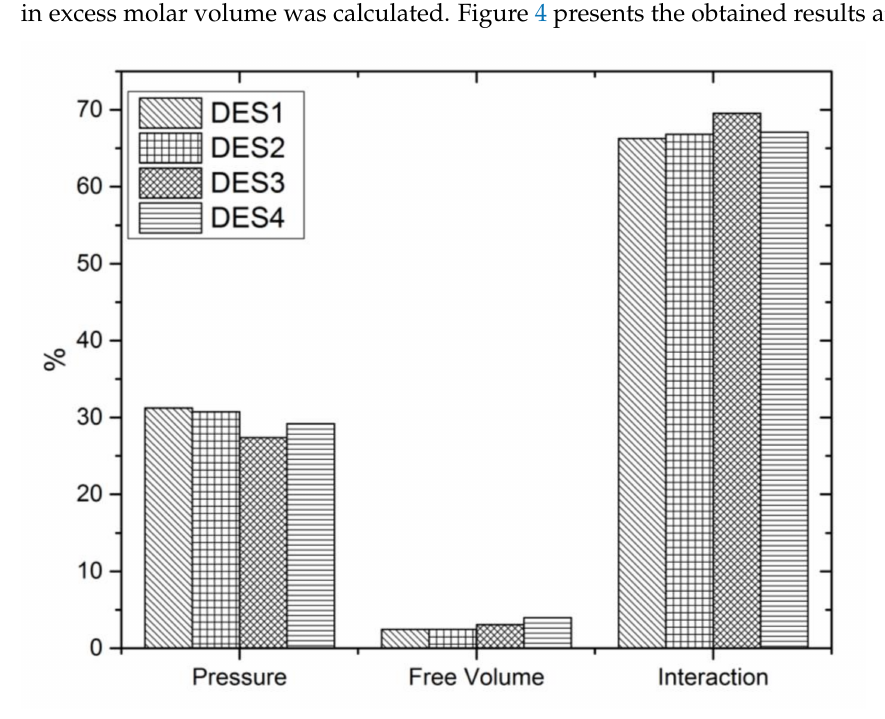
Figure 4. Percentages of the three contributions in excess molar volume of aqueous solutions of DESs for x 1 = 0.4 at 298.15